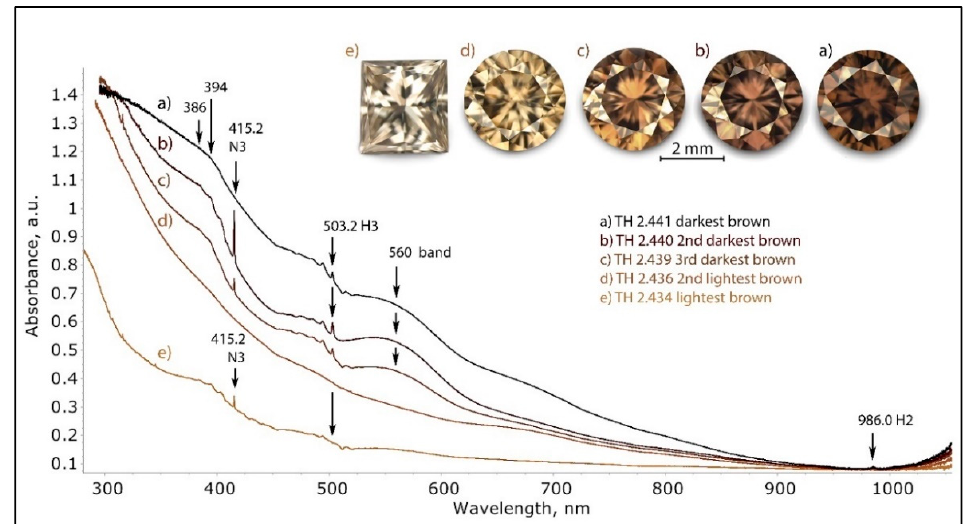
Figure 13. The UV-Vis-NIR spectra of stones from the color suite shown in Figure 7 demonstrate that the darkness of the brown diamonds is represented by the steepness of the absorption continuum. The spectra shown are the most common type of UV-Vis-NIR spectra, with a characteristic continuum, weak N3 and H3 absorption and often a detectable 560 nm band. The spectra were shifted vertically for clarity.